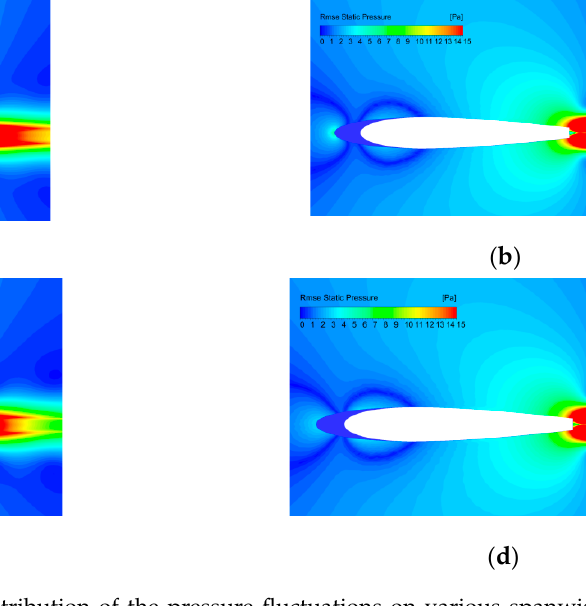
Figure 12. Distribution of the pressure fl uctuations on various spanwise sections: ( a ) baseline; ( b ) A10W10 peak; ( c ) A10W10 middle; ( d ) A10W10